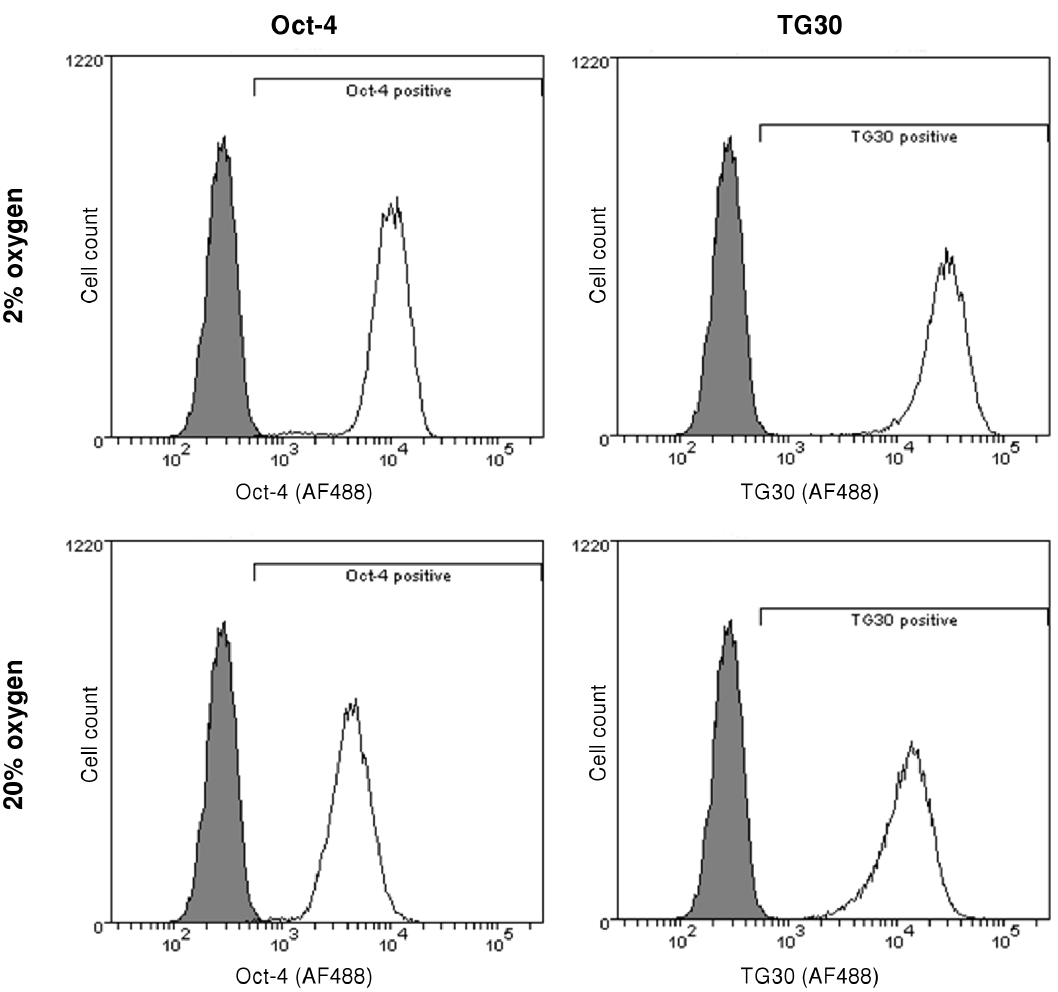
Figure 1. Pluripotent marker expression of human embryonic stem cells. Pluripotent marker expression of hESCs cultured under physiological, 2%, and atmospheric, 20%, oxygen concentrations were tested by FACS analysis after the completion of each experiment to ensure that the cells remained pluripotent throughout the 100 hour experiment. Representative FACS plots showing the shift in marker expression from the negative controls at the endpoint of an experiment are shown. All cell samples were found to be 92–99% positive for both TG30 and Oct-4 after each experiment at both 2% and 20% oxygen.